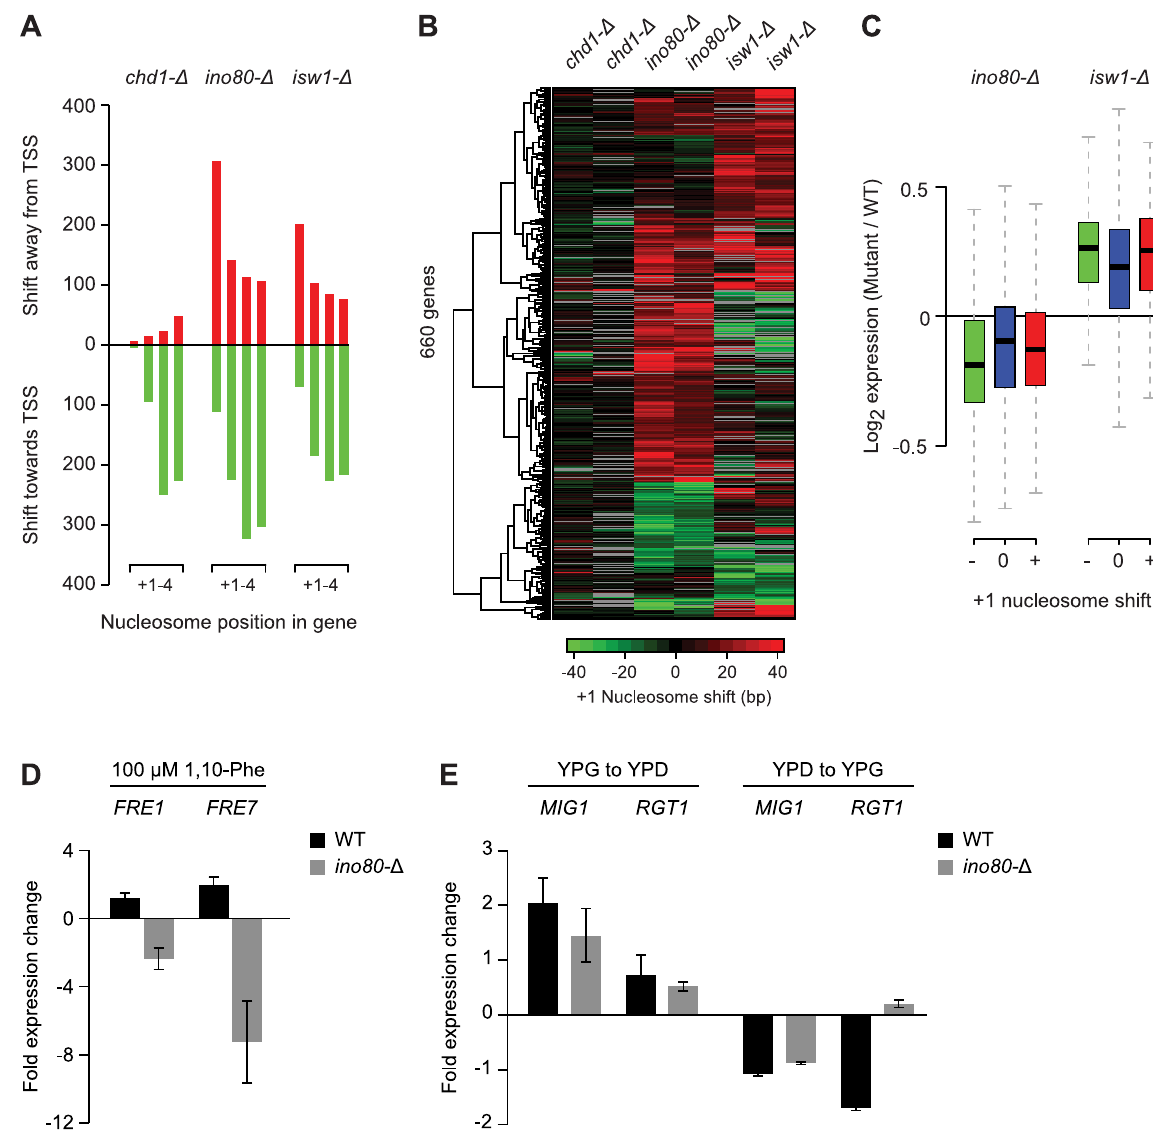
Figure 3. Loss of Ino80 or Isw1 leads to + 1 nucleosome shifts at a subset of genes. A) Number of + 1 to + 4 nucleosomes with significant shifts in strains bearing deletions of the remodeler ATPases Chd1, Ino80 or Isw1, compared to 36 WT conditions. B) Hierarchical clustering of shifts at + 1 nucleosomes found as significant in at least one of the remodeler ATPase mutants. Two biological replicates, each grown on different days, are shown for each mutant. The direction and degree of shift relative to the transcription start site is indicated by the color bar. Positions for which a shift could not be determined because of absent nucleosome calls in WT or mutant strains are colored grey. C) Box plot of the change in expression for genes with positive (red) or negative (green) + 1 nucleosome shifts in ino80- D or isw1- D strains, compared to genes without shifts (blue). Box and whisker definitions follow those in Figure 2. D) qPCR analysis of FRE1 and FRE7 expression changes after 30 min treatment with 100 m M 1,10- phenantroline in a WT or ino80- D background. E) qPCR analysis of MIG1 and RGT1 expression changes upon shifts from YPG to YPD (left) or YPD to YPG (right) in a WT or ino80- D background. changes (data not shown). We attribute this to the fact that the effects of nucleosome repositioning may be activating or inhibi- tory, depending on local sequence context, e.g. on whether